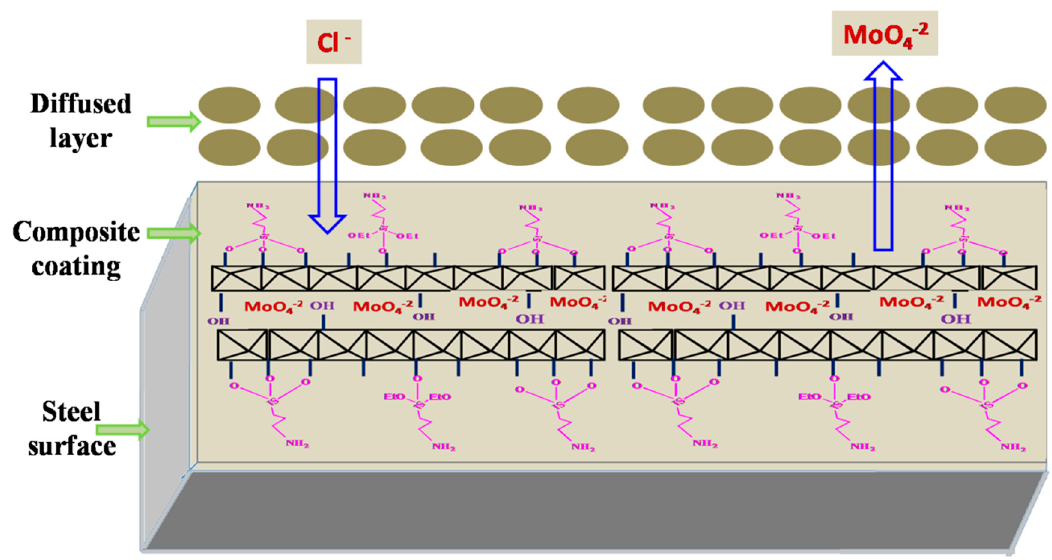
Figure 8. Schematic for the mechanism of corrosion inhibition by APTES–Mo–LDH/epoxy composite coating.